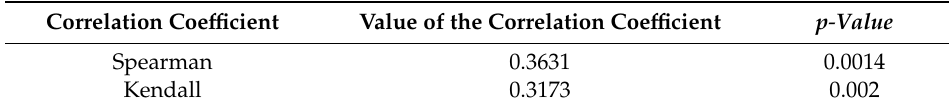
Table 2. The values of the correlation coe ffi cients between the amount of costs incurred for innovations and the increase in annual gross sales of a family business.